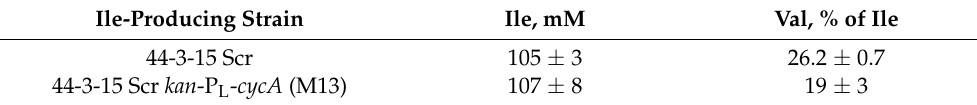
Table 3. Influence of cycA overexpression on Val accumulation by Ile-producing strain